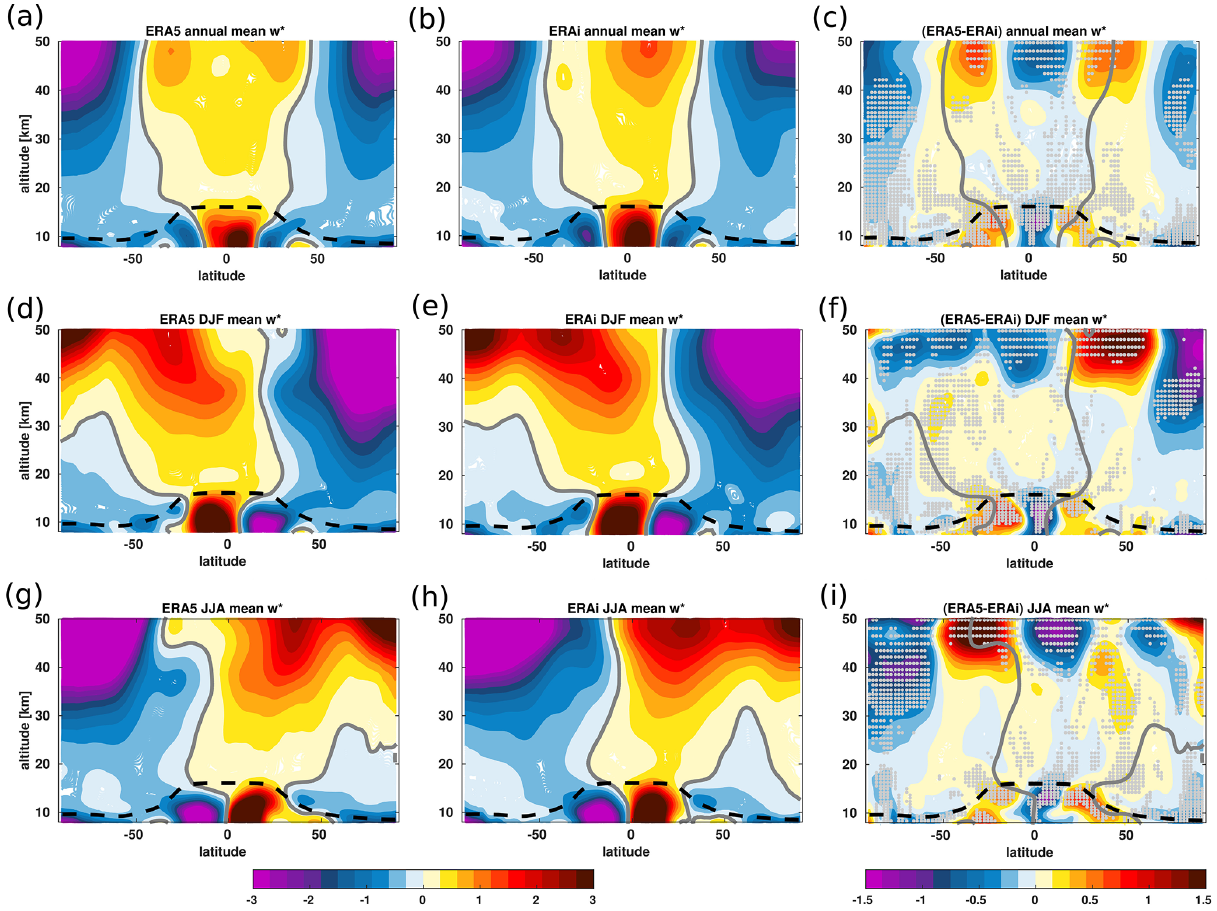
Figure 1. Annual (a, b) , DJF (d, e) , and JJA (g, h) mean variations of the residual vertical velocity ( w ∗ in mms − 1 ) from the ERA5 (left column) and the ERA-Interim (middle column) reanalyses together with the associated differences (c, f, i) between the ERA5 and the ERA- Interim reanalyses (right column) for the 1979–2018 time period. Grey line indicates the zero w ∗ contours. Grey dots in panels (c, f, i) indicate regions where the differences between the ERA5 and ERA-Interim reanalyses are statistically significant at 95% estimated using Student’s t test. The climatological tropopause from the ERA-Interim is indicated as the dashed black horizontal